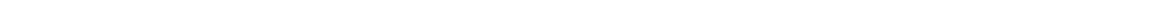
Fig. 2 Dxz4 deletion or inversion changes contact distribution on the Xi. a Contact maps (500 kb resolution) for the Xi in WT*, Del-hinge/Dxz4, and Inv- Dxz4 visualized using Pearson correlation to highlight contact probabilities. The color scale shows Pearson correlation values. b Pearson correlation- transformed contact maps (500 kb resolution) for 50 Mb around the Dxz4 locus to highlight the loss of superdomain structure in Del-hinge/Dxz4 and the shift in contacts in Inv-Dxz4, where a new contact domain forms between Firre and Dxz4 . The color scale shows Pearson correlation values. c Allelic principal component (PC) score pro fi les for the Xa and Xi chromosomes in WT*, Del-hinge/Dxz4, and Inv-Dxz4, based on distance-corrected, normalized contact maps with counts binned at 500 kb resolution. For the Xa, the top three allelic PC scores are shown in red, blue, and green, respectively. For the Xi, PC1 score pro fi les are plotted in black to emphasize that PC1 captures the bipartite structure rather than A/B compartments in WT*, and PC2-4 are shown in red, blue, and green, respectively. See Supplementary Fig. 3a for analysis of the variance in the PC score pro fi les of the X chromosomes and Supplementary Fig. 3b, c for analyses of autosomes. d Pair-wise Spearman correlation values and associated scatter plots between allelic PC1 scores for the Xa and Xi in WT*, Del-hinge/Dxz4, and Inv-Dxz4. Xi PC1 scores are less correlated between WT* and Del-hinge/Dxz4 (Spearman ρ = 0.35) compared to those of Xa ( ρ = 0.95) and autosomes ( ρ > 0.9). The Xi PC1 score in Inv-Dxz4 is less correlated with the WT* Xi PC1 pro fi le ( ρ = 0.75) than Xa PC1 scores ( ρ = 0.94), indicative of changes in Xi-speci fi c long-range contacts. See Supplementary Fig. 3d for analysis of autosomes. e – h . Plots of the average Hi-C interaction frequencies (at 500 kb resolution) as a function of genomic distance along the Xa (dotted line) and Xi (line) for WT* (blue), Del-hinge/Dxz4 (red), and Inv-Dxz4 (black) for the entire length of the X chromosomes ( e ) and for three regions along the X chromosome: Firre-Xist (~53 Mb, f ); Firre-Dxz4 (~25 Mb, g ); Dxz4-Xist (~28 Mb, h ). Inset: plots of average contacts as a function of distance for